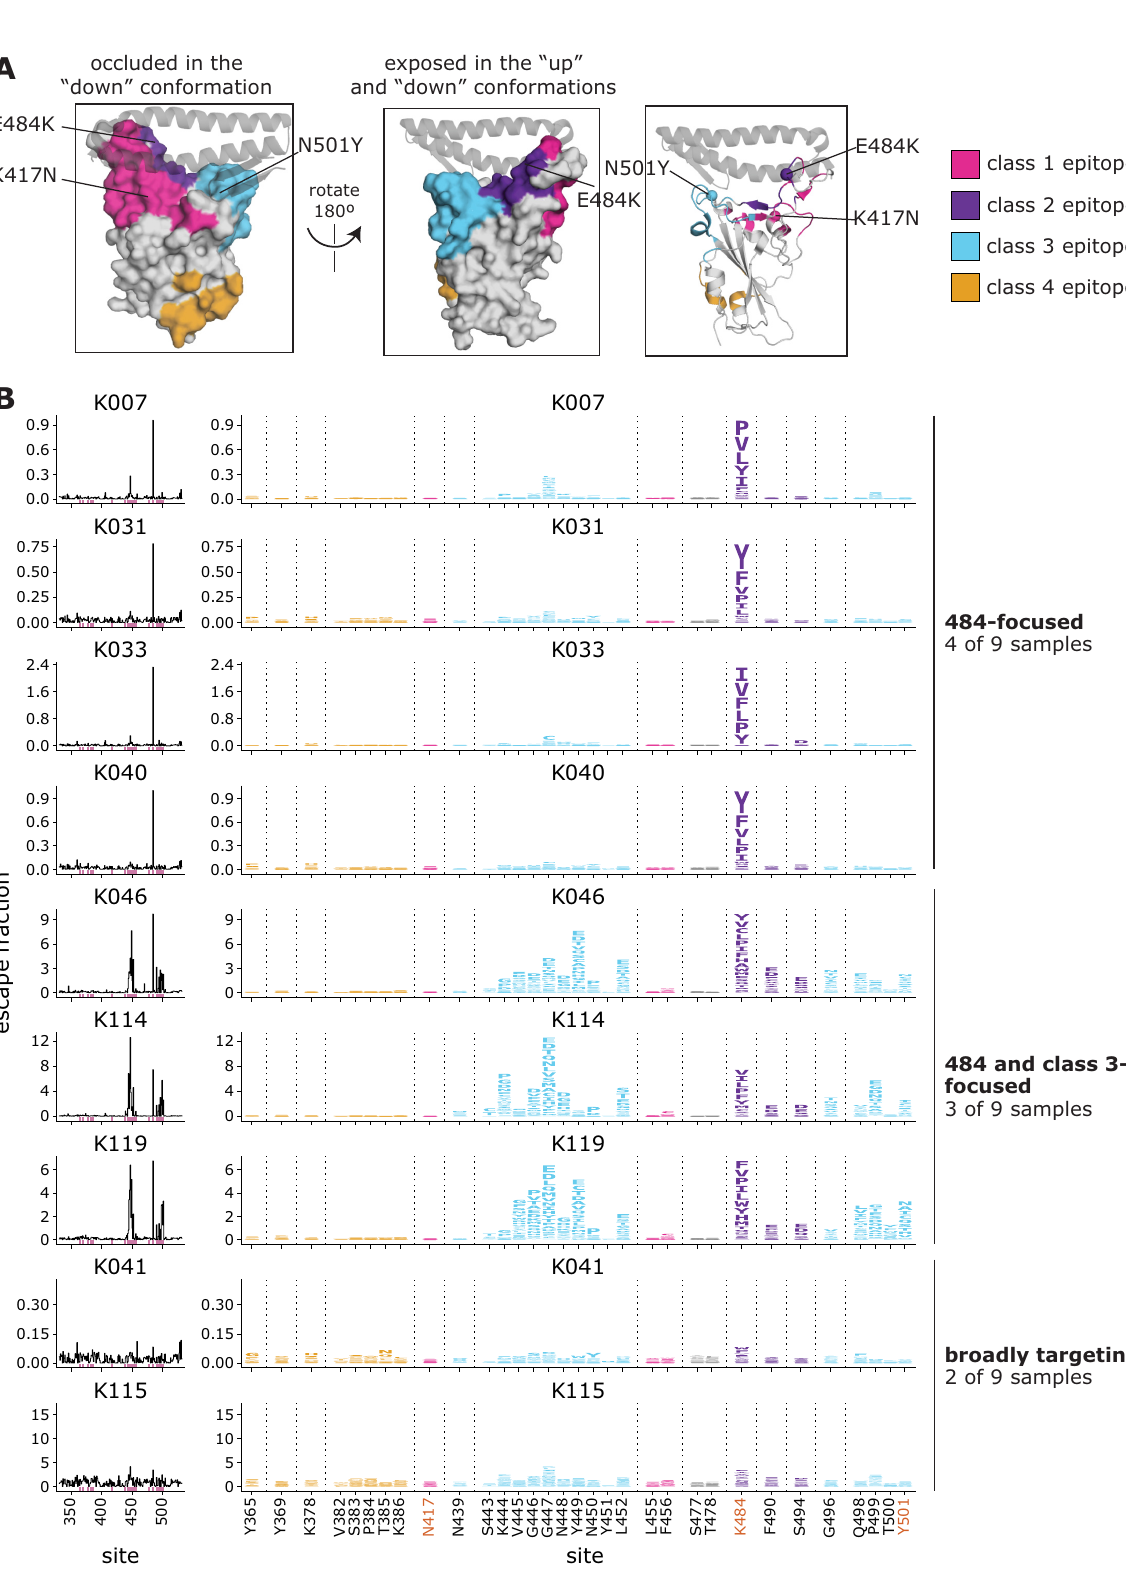
Fig 3. Complete maps of mutations in the B.1.351 RBD that reduce binding by B.1.351 convalescent plasmas. (A) The Wuhan-Hu-1 RBD (PDB 6M0J) colored by antibody epitope [23]. The three sites where mutations distinguish the Wuhan-Hu-1 and B.1.351 RBDs are labeled.